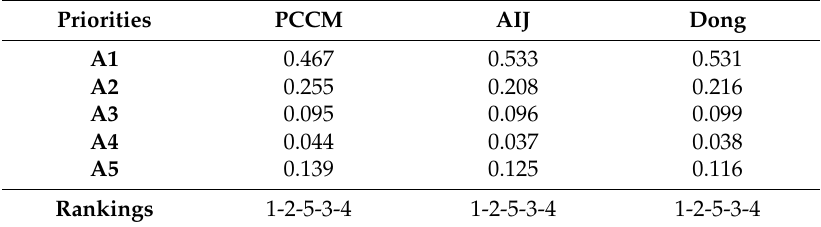
Table 4. Priority vectors and rankings for the AHP-GDM procedures.